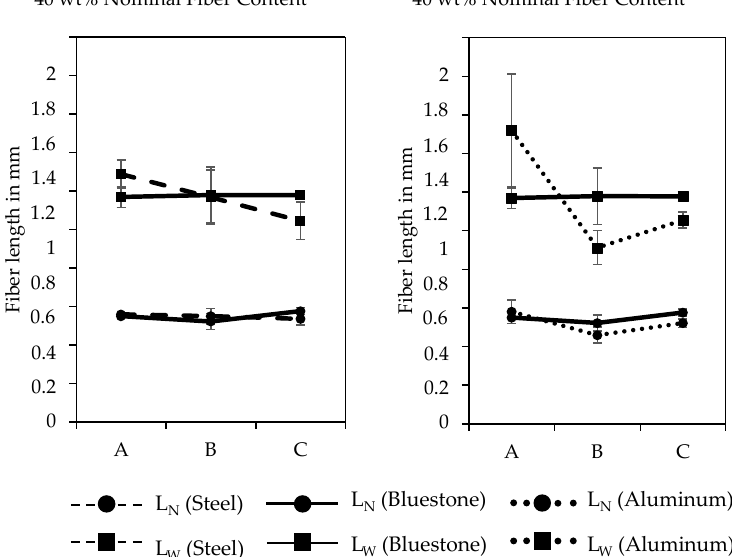
Figure 18. Fiber length (N = number average; W = weight or length average) for different tool types (for better representation in two diagrams) with 40 wt.% nominal fiber content at different specimen locations A, B, and C in accordance with Figure 7.